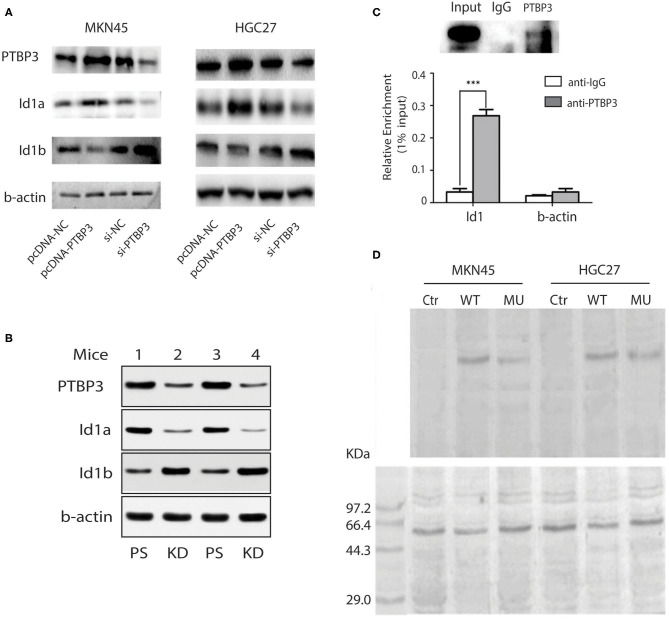
PTBP3 modulates Id1 alternative splicing via binding to its intronic region. (A) Immunoblots showed Id1a and Id1b protein expression levels after altering the PTBP3 expression level in two gastric cancer cells. (B) Western blot analysis of Id1a, Id1b, and PTBP3 expressed in mouse tumors from different PTBP3 knockdown and pSliencer vector-transfected mice. (C) RIP experiments were performed using the PTBP3 antibody to immunoprecipitate (IP) in total-cell extracts of MKN45 cells, and relative enrichment was determined by reverse transcription PCR (upper panel) and quantitative real-time PCR (lower panel). The results are expressed as the mean ± S.D. of three independent experiments. ***P < 0.001. (D) UV cross-linking was performed using 2 pmol 32P-labeled RNA and 50 μg of protein extracts. The immunoprecipitates were subjected to SDS–PAGE followed by autoradiography (upper panel), and the samples were immunoprecipitated with anti-PTBP3 (lower panel). The negative control (Ctr) only has the same amount of protein extracts.